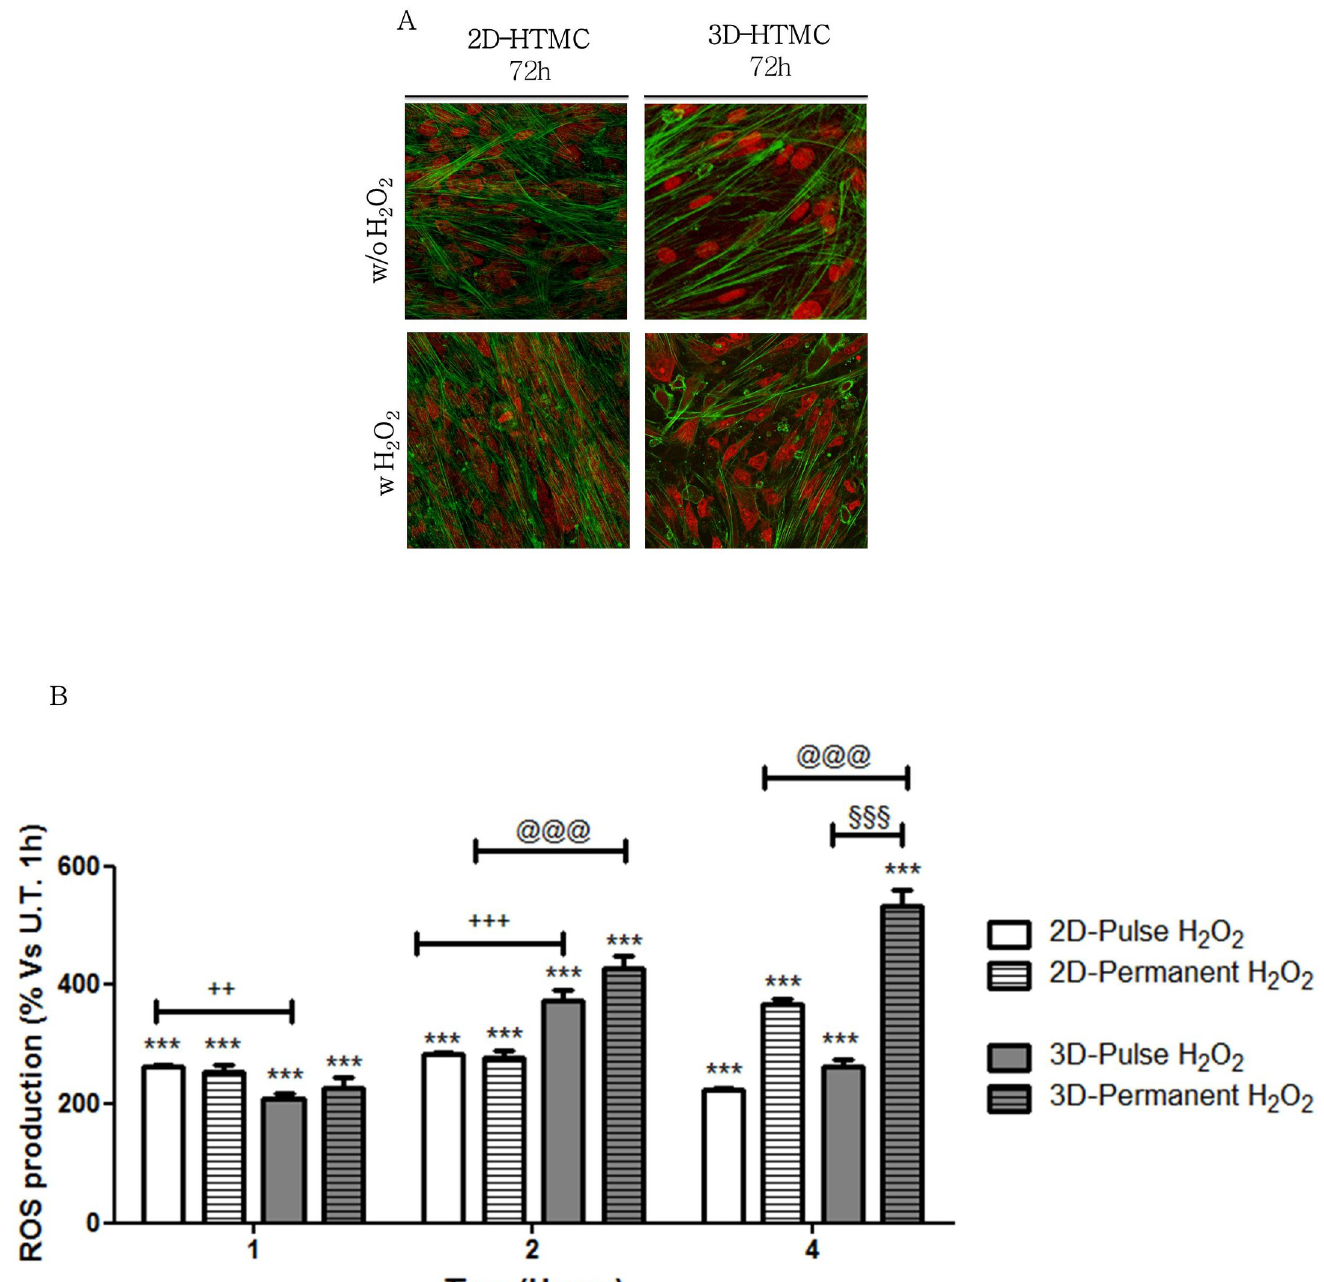
Fig 1. 2D- and 3D-HTMC oxidative stress sensitivity. Panel A- Confocal microscopy analyses of nucleus and cytoskeletal markers were performed on untreated and H 2 O 2 -treated 2D- and 3D HTMC cells after 72 hrs of experimental procedures. Representative images are related to immunoreactivity for To-Pro TM and Phalloidin, as nuclear and cytoskeleton markers, respectively. Merged images showed cytoskeleton plus Nucleus. Fluorescence signals were captured at 60x magnification. Panel B- DCF assay. DCF assay was performed on untreated and H 2 O 2 (U.T.)-treated 2D- and 3D HTMC cells and the fluorescence was recorded at 1, 2 and 4 hrs of experimental procedures. Data are expressed as % of ROS production in untreated HTMCs after 1hr and represent the mean ± SD of 3 independent experiments, each performed six times. White and grey bars = 2D and 3D cultures, respectively ��� p < 0.001 vs respective untreated cultures (1h); §§§p < 0.001 3D- permanent